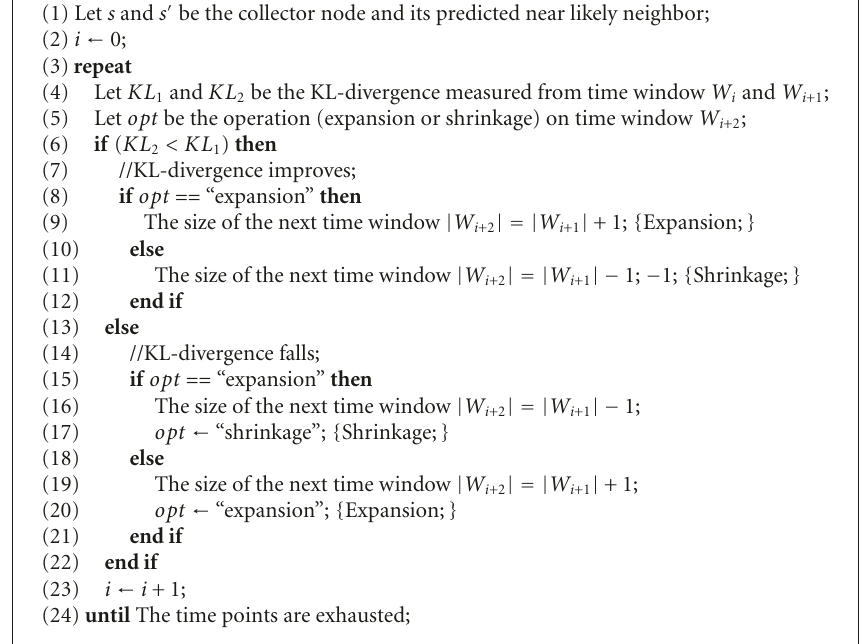
Algorithm 1: The WINTER